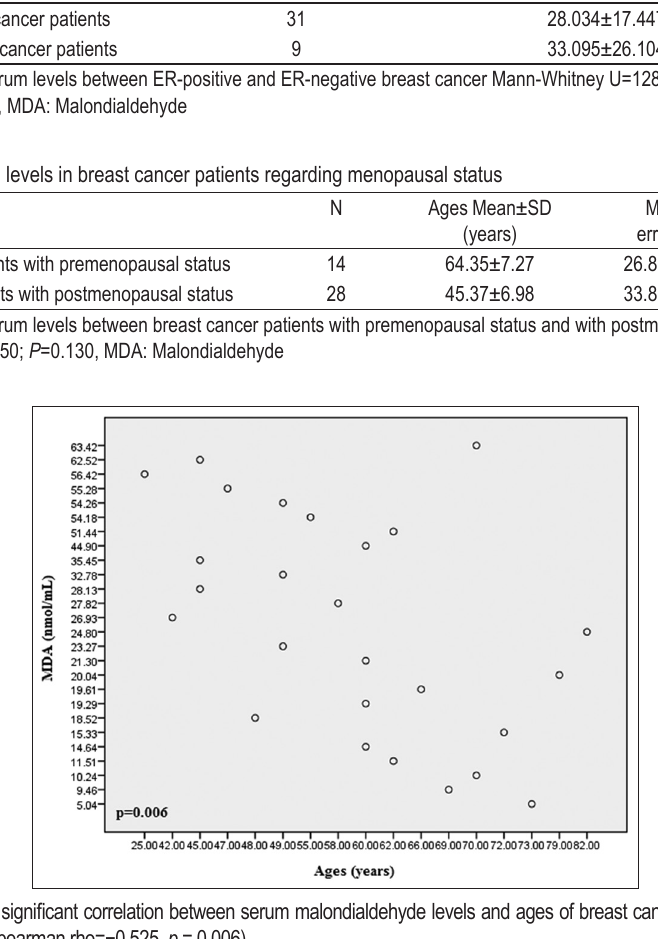
TABLE 4. MDA serum levels in breast cancer patients with positive and negative ERs Group N